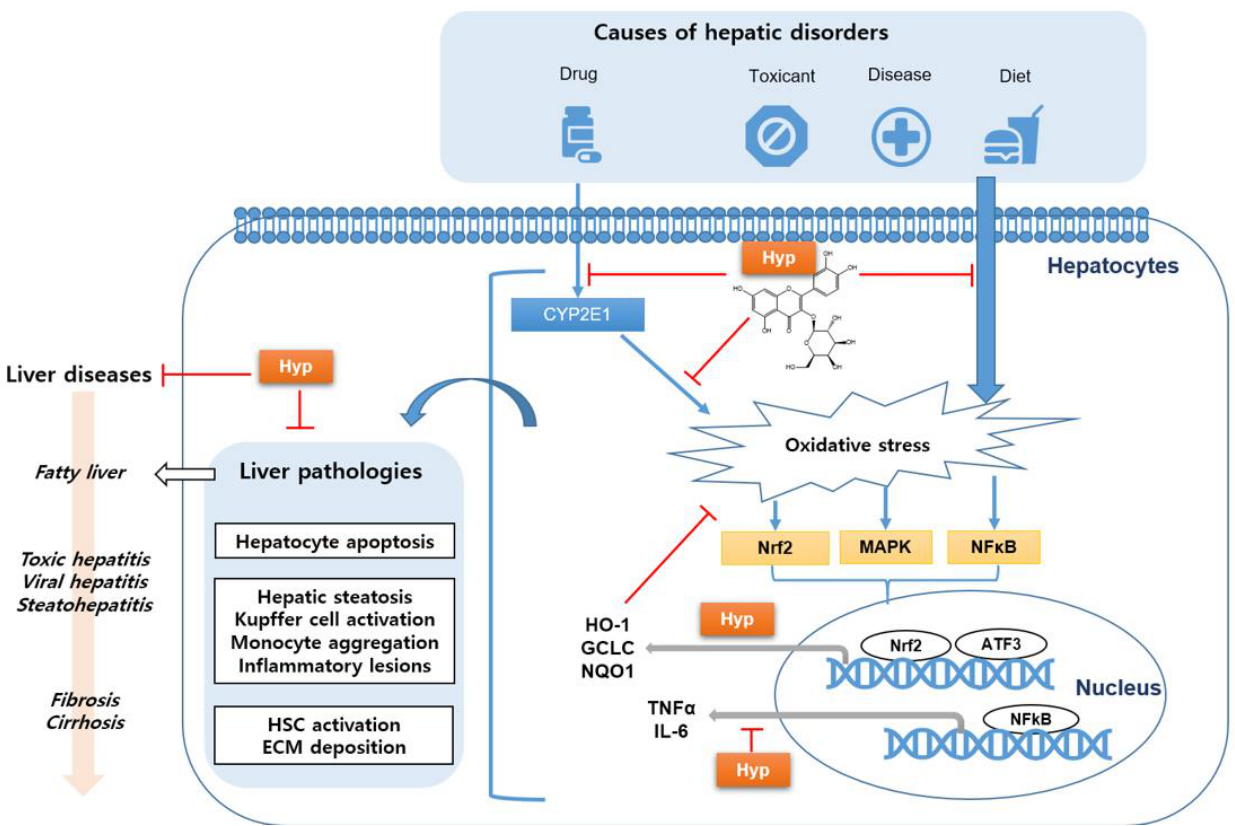
Figure 4. Schematic diagram of hyperoside (Hyp), which improves various liver diseases by reduc- ing oxidative stress; CYP, cytochrome P450; Nrf2, nuclear factor erythroid 2-related factor 2; MAPK, mitogen-activated protein kinase; NF κ B, nuclear factor kappa-light-chain-enhancer of activated B cells; HO-1, heme oxygenase-1; GCLC, glutamate–cystein ligase catalytic subunit; NQO1, NAD(P)H quinone dehydrogenase 1; TNF- α , tumor necrosis factor-alpha; IL-6, interleukin-6; ATF3, cyclic AMP-dependent transcription factor; HSC, hepatic stellate cell; and ECM, extracellular matrix.